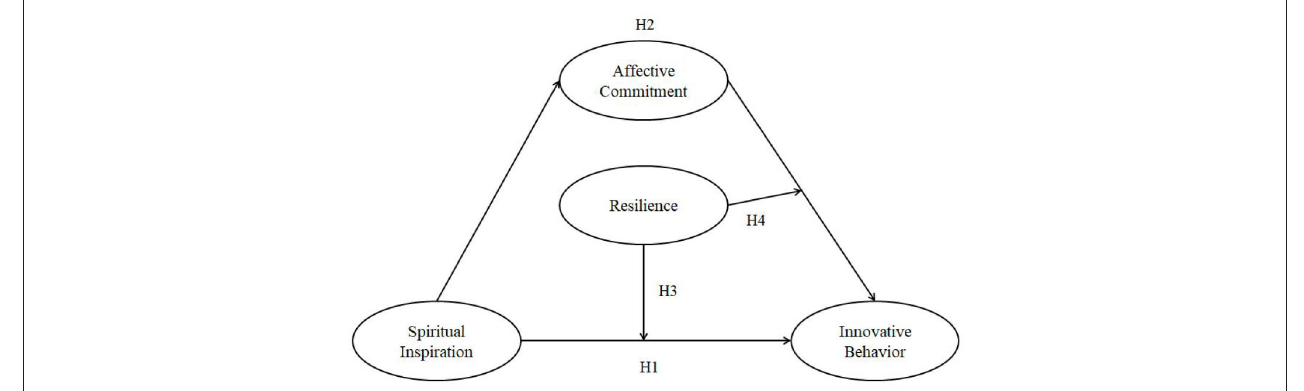
FIGURE 1 | Research model.